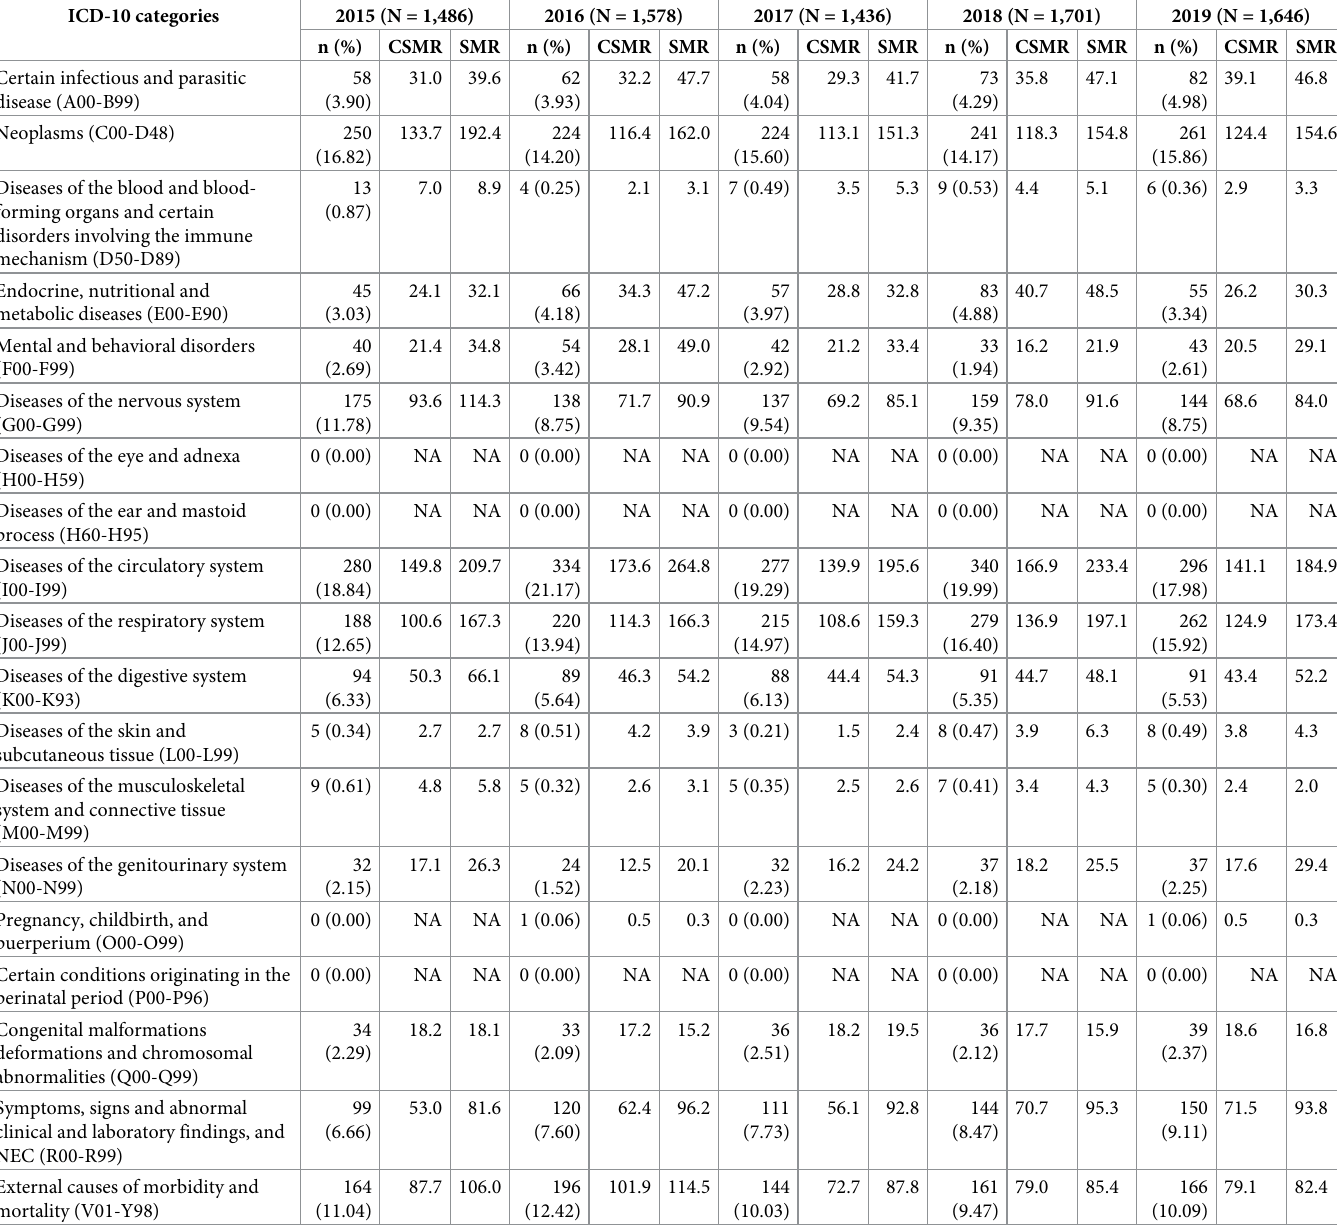
Table 3. Causes of death among people with intellectual disabilities based on ICD-10 codes from 2015 to 2019. ICD-10